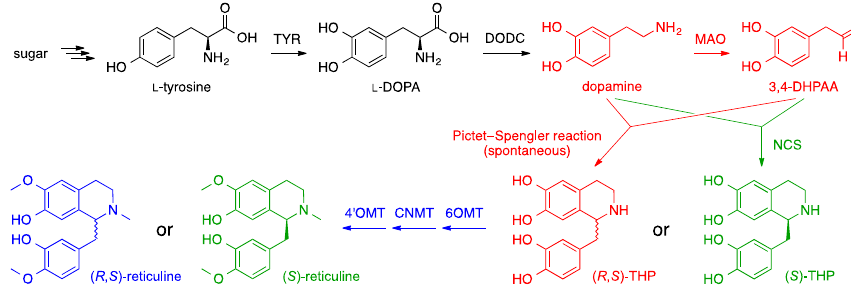
Figure 16. Heterologous biosynthetic pathway established in E. coli for de novo production of ( R , S )-reticuline from simple sugar using a three-step fermentation method [81–83]. The three fermentation steps are designated by three different colors: black for the dopamine production step, red for the ( R , S )-THP production step and blue for the ( R , S )-reticuline production step. The initial attempt to use the norcoclaurine synthase (NCS) for the production of ( S )-THP for the preparation of ( S )-reticuline (shown in green) was replaced by the use of a spontaneous intracellular Pictet-Spengler reaction (shown in red) that resulted in the eventual formation of ( R , S )-reticuline (shown in blue). Subsequent biosynthesis of thebaine and hydrocodone followed the same biosynthetic scheme shown in Figures 15 and 14, respectively. MAO, monoamine oxidase.